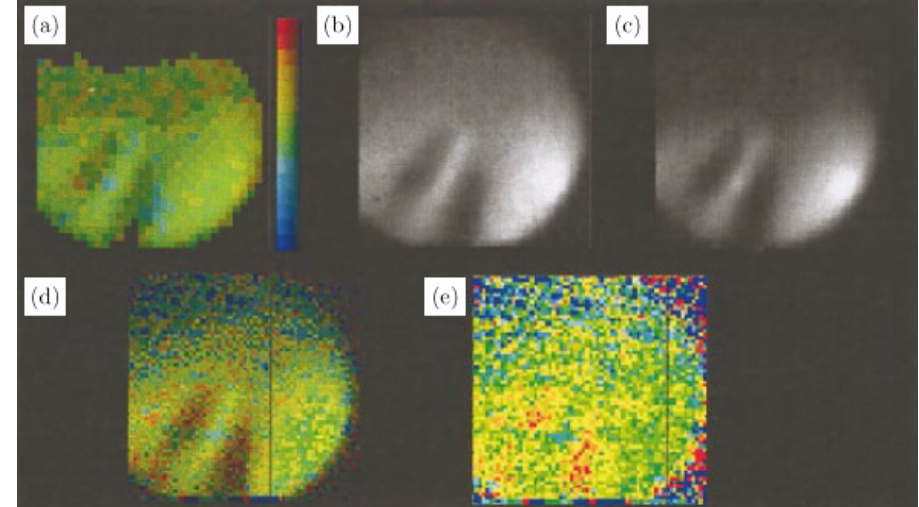
Fig. 12. Fluorescence lifetime imaging of anterior basal bronchus endoscopy. Blue – green represents normal tissue. 48 (a) Apparent °uorescence lifetime image calculated during the endoscopic examination, based on the demodulation; (b) and (c) °uorescence and backscattered intensity images; (d) apparent °uorescence lifetime image recalculated after the examination; (e) apparent °uores- cence lifetime image recalculated after the examination without intensity weighting (Permission has been granted by \AIP Pub- lishing LLC" through Copyright Clearance Center's RightsLink r